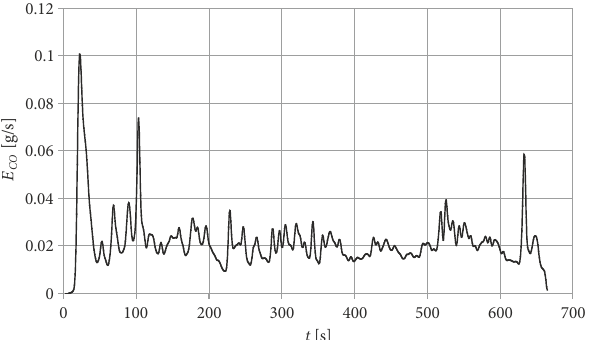
Figure 11. Time history of the carbon monoxide emission intensity E CO in the CT1 test